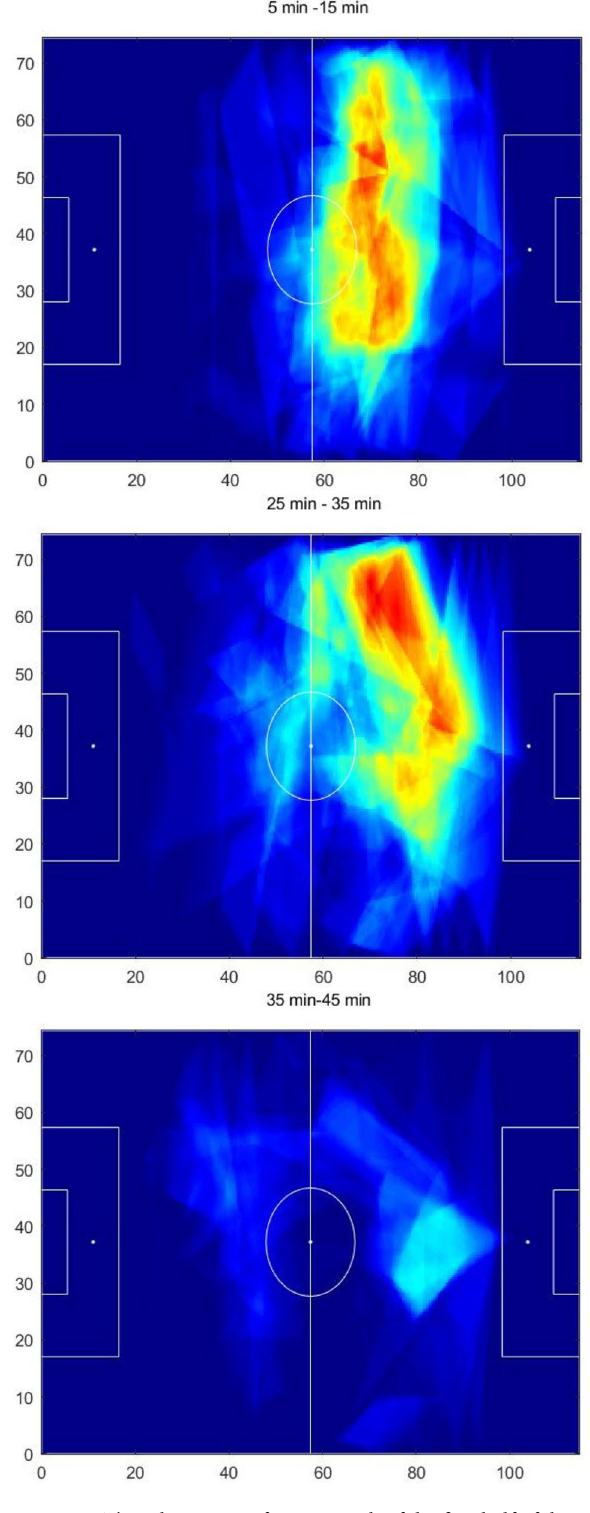
Figure 3. Three heatmaps of 10 min each of the first half of the 4th match representing minutes 5 through 15 (top figure), 25 through 35 (mid figure), and 35–45 (bottom figure). In these heatmaps the dark red area represents areas that were under potential passes for 30 s or